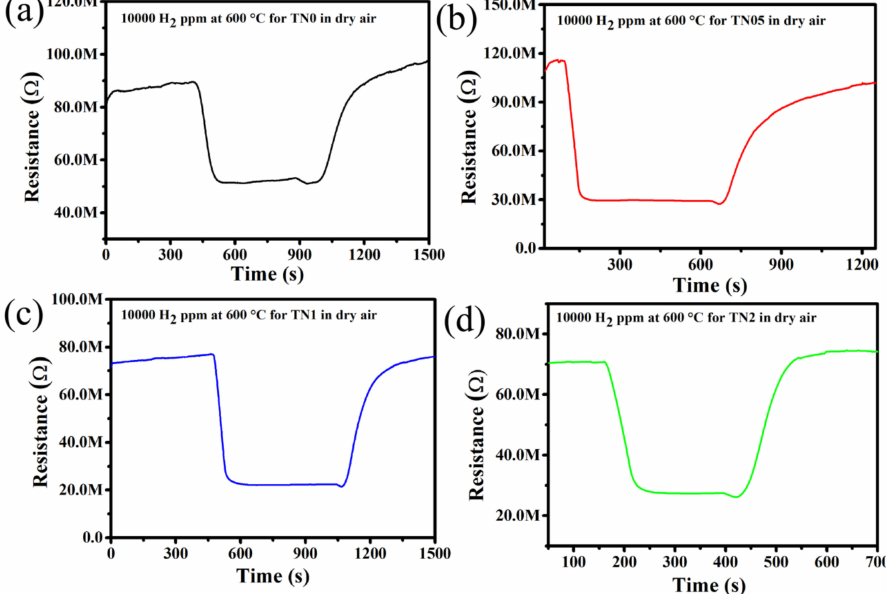
Figure 5. Dynamic response toward 10,000 ppm H 2 at 600 ◦ C for ( a ) undoped TiO 2 , ( b ) 0.5% Ni-doped TiO2-TN05, ( c ) 1.0% Ni-doped TiO2-TN1 and ( d ) 2.0% Ni-doped